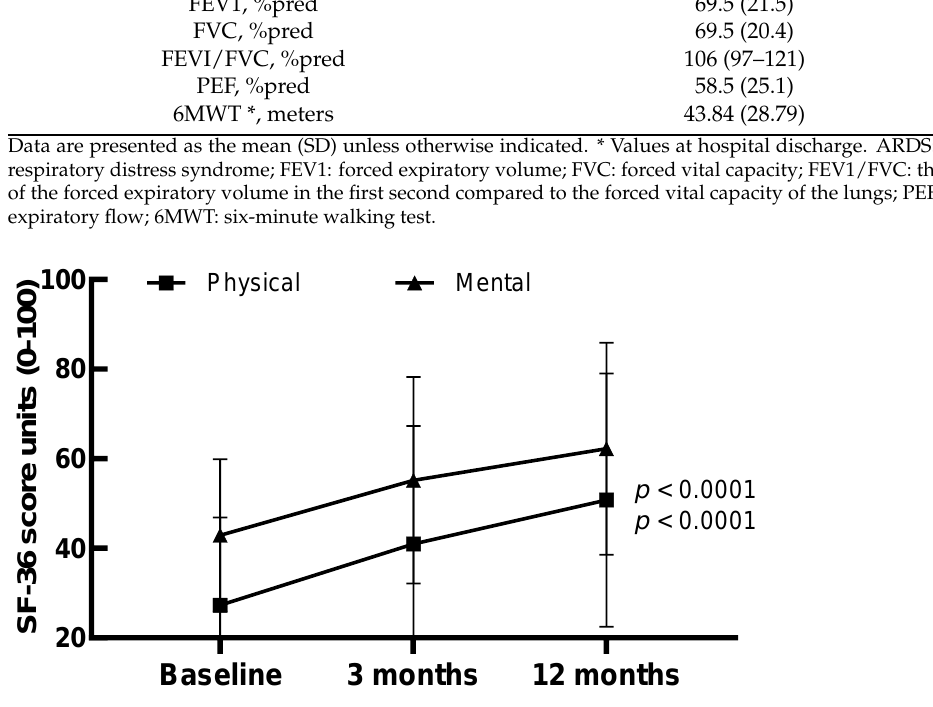
Figure 2. Physical and mental health scores of participants at different time points following ICU discharge. Data are presented as mean (SD) values.